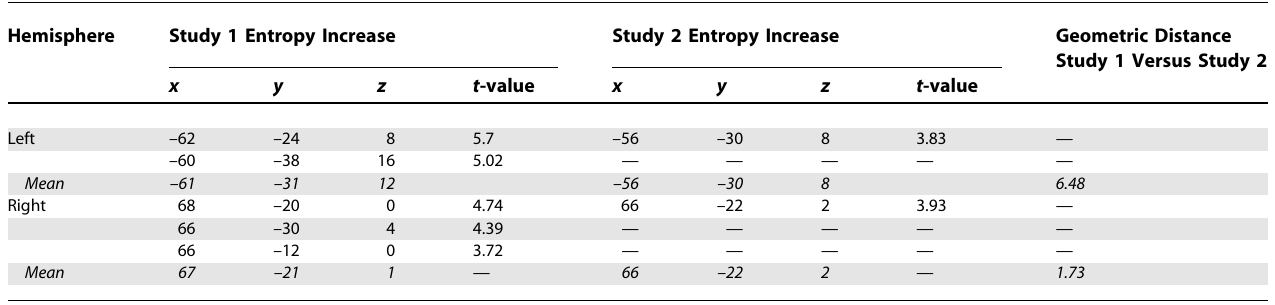
Table 2. MNI Coordinates in